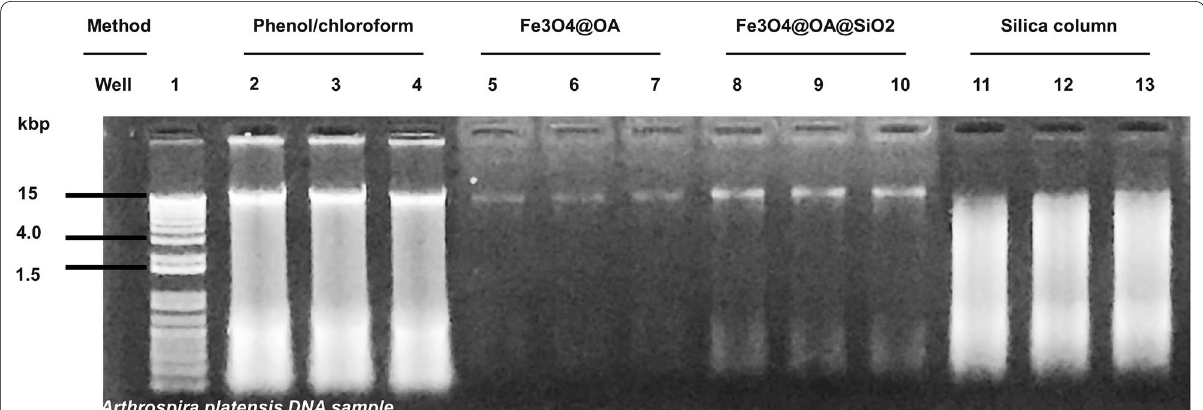
Fig. 6 Agarose gel electrophoresis of DNA isolated from Arthrospira platensis . Lane 1: 1 kb plus DNA ladder (Invitrogen); DNA are extracted through